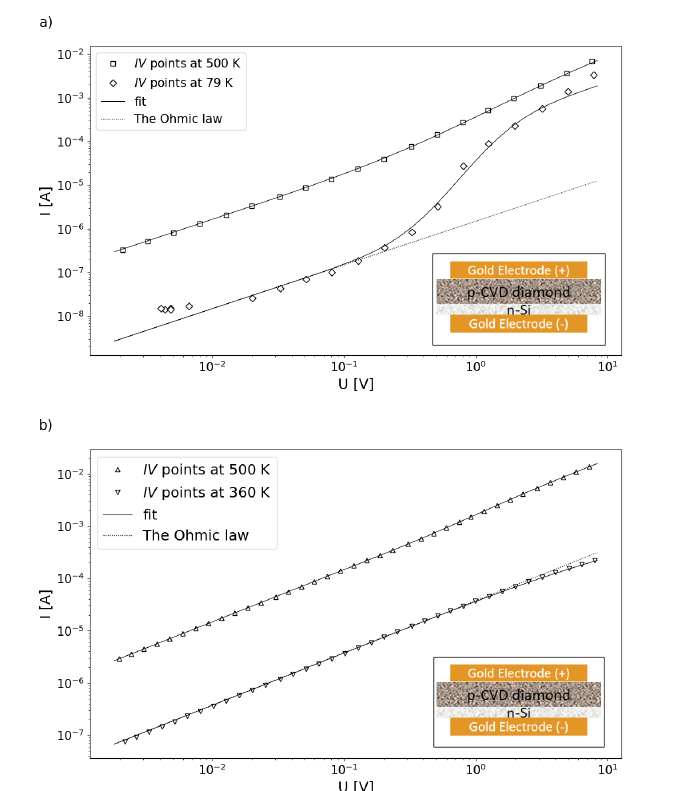
Figure 5. Details of I − V − T characteristics for selected temperatures of ( a ) DFI and ( b ) DFII developed heterojunctions respectively. Insets: the scheme of the heterojunction structure.